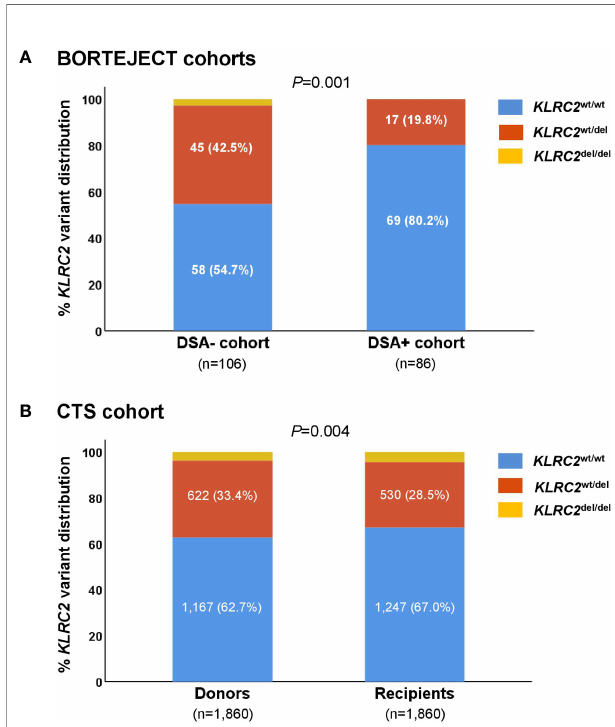
FIGURE 2 | Recipient KLRC2 variant distribution among (A) donor-speci fi c antibody (DSA)+ study patients versus propensity score-matched DSA – control subjects (patients selected from the BORTEJECT trial), and (B) donors versus recipients of the Collaborative Transplant Study (CTS) study cohort. Genotype frequencies in the CTS recipient population deviated from Hardy Weinberg equilibrium ( P = 0.008), but not the donor-speci fi c antibody (DSA)+ ( P = 0.31), DSA – ( P =0.10) and CTS donor cohorts ( P = 0.29),